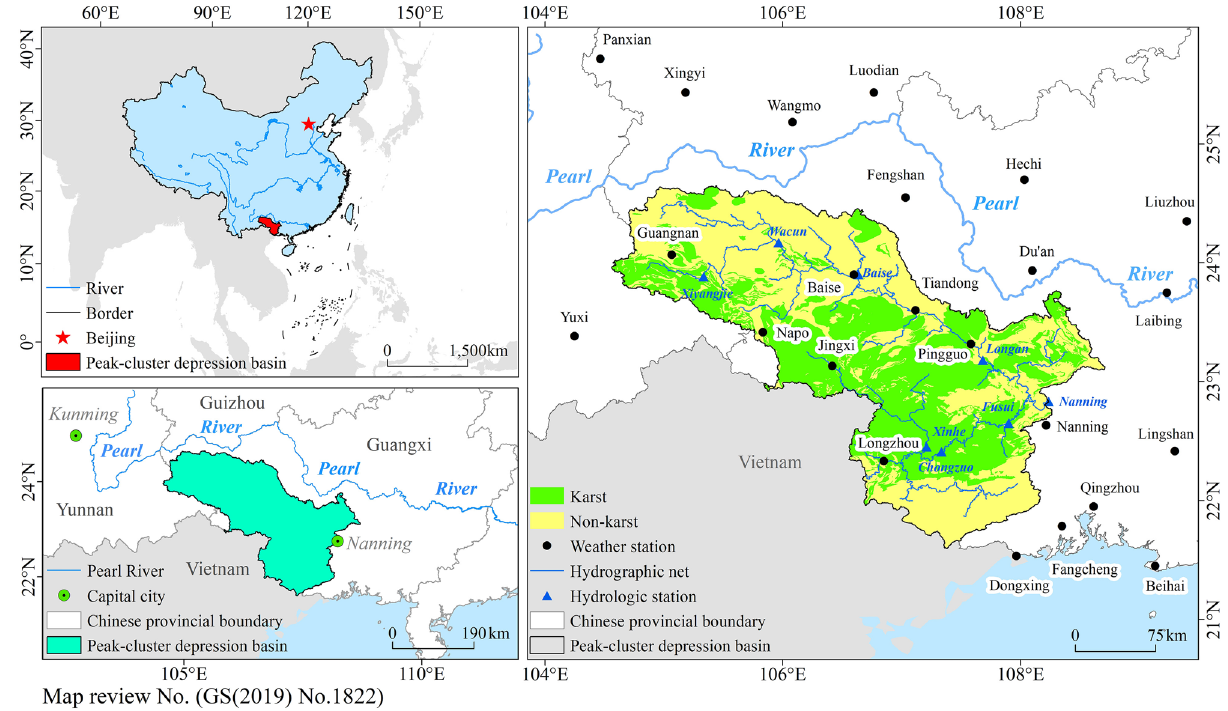
Figure 6. The location of the study area. Maps were generated using QGIS 3.26.2 (https:// www. qgis. org/ en/